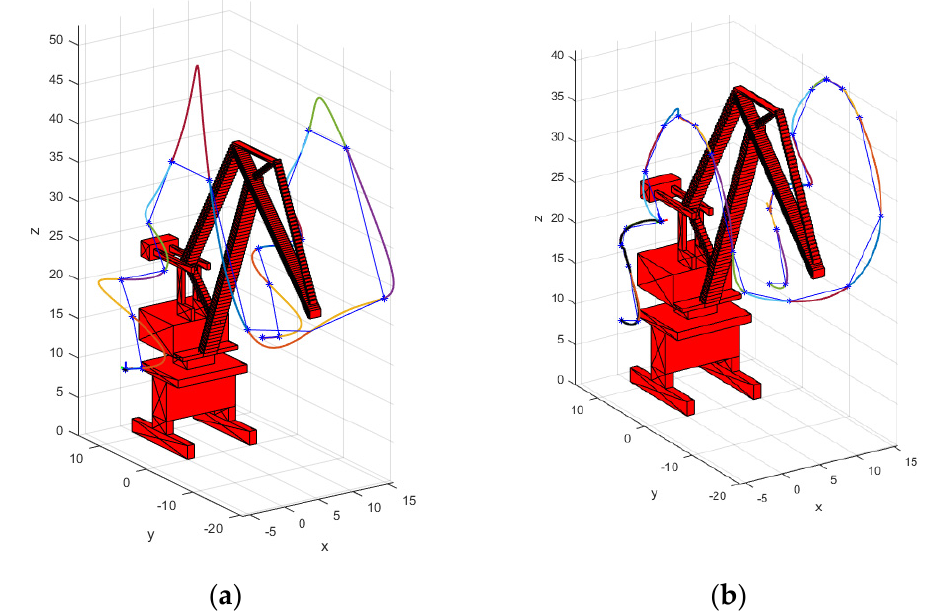
Figure 8. Comparison of trajectory optimization simulation results: ( a ) trajectory before method improvement; ( b ) improved trajectory.